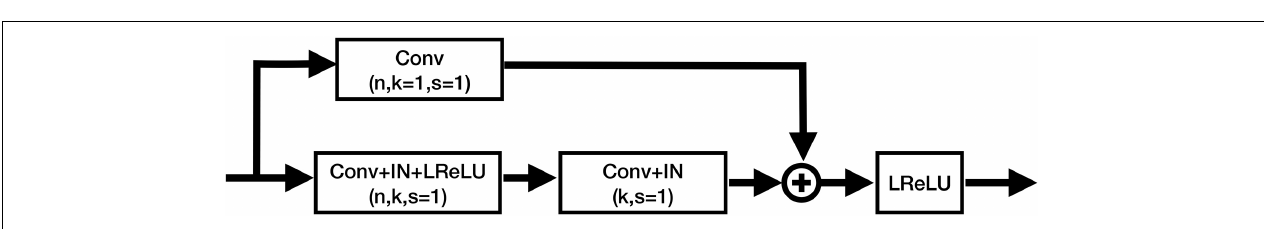
FIGURE 3 | Structure of the residual blocks in CAU-Net. Conv, ConvTrans, IN, and LReLU denote the convolution layer, transposed convolution layer, instance normalization, and Leaky ReLU activation function, respectively. “+” denotes the element-wise addition.